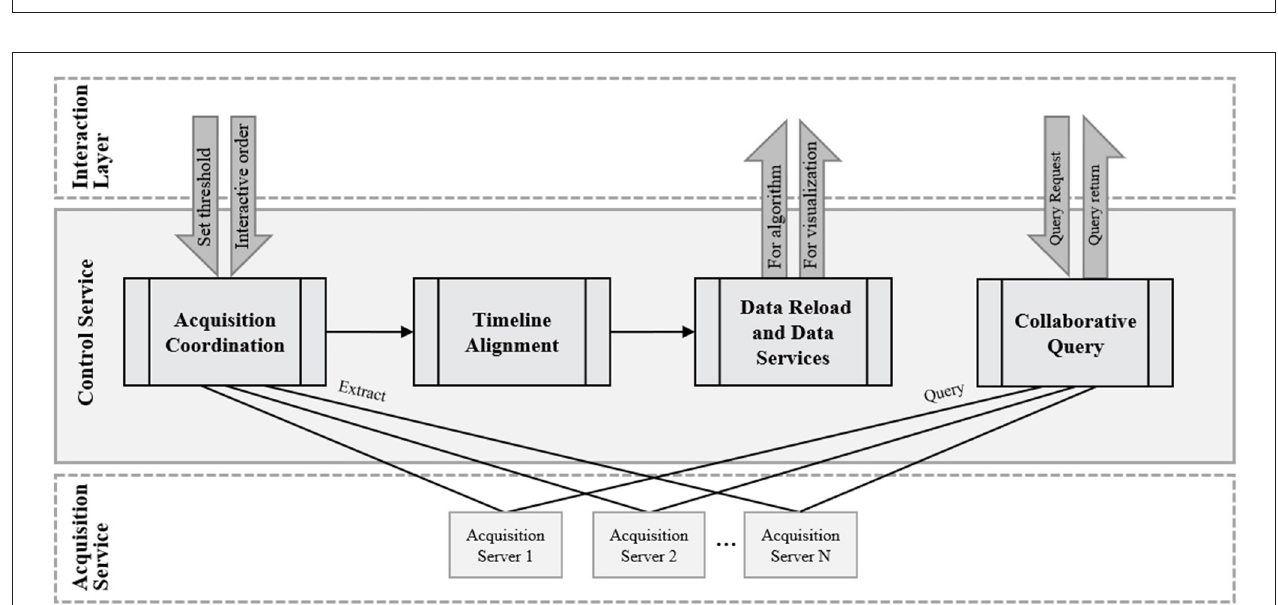
FIGURE 4 | The flow of control